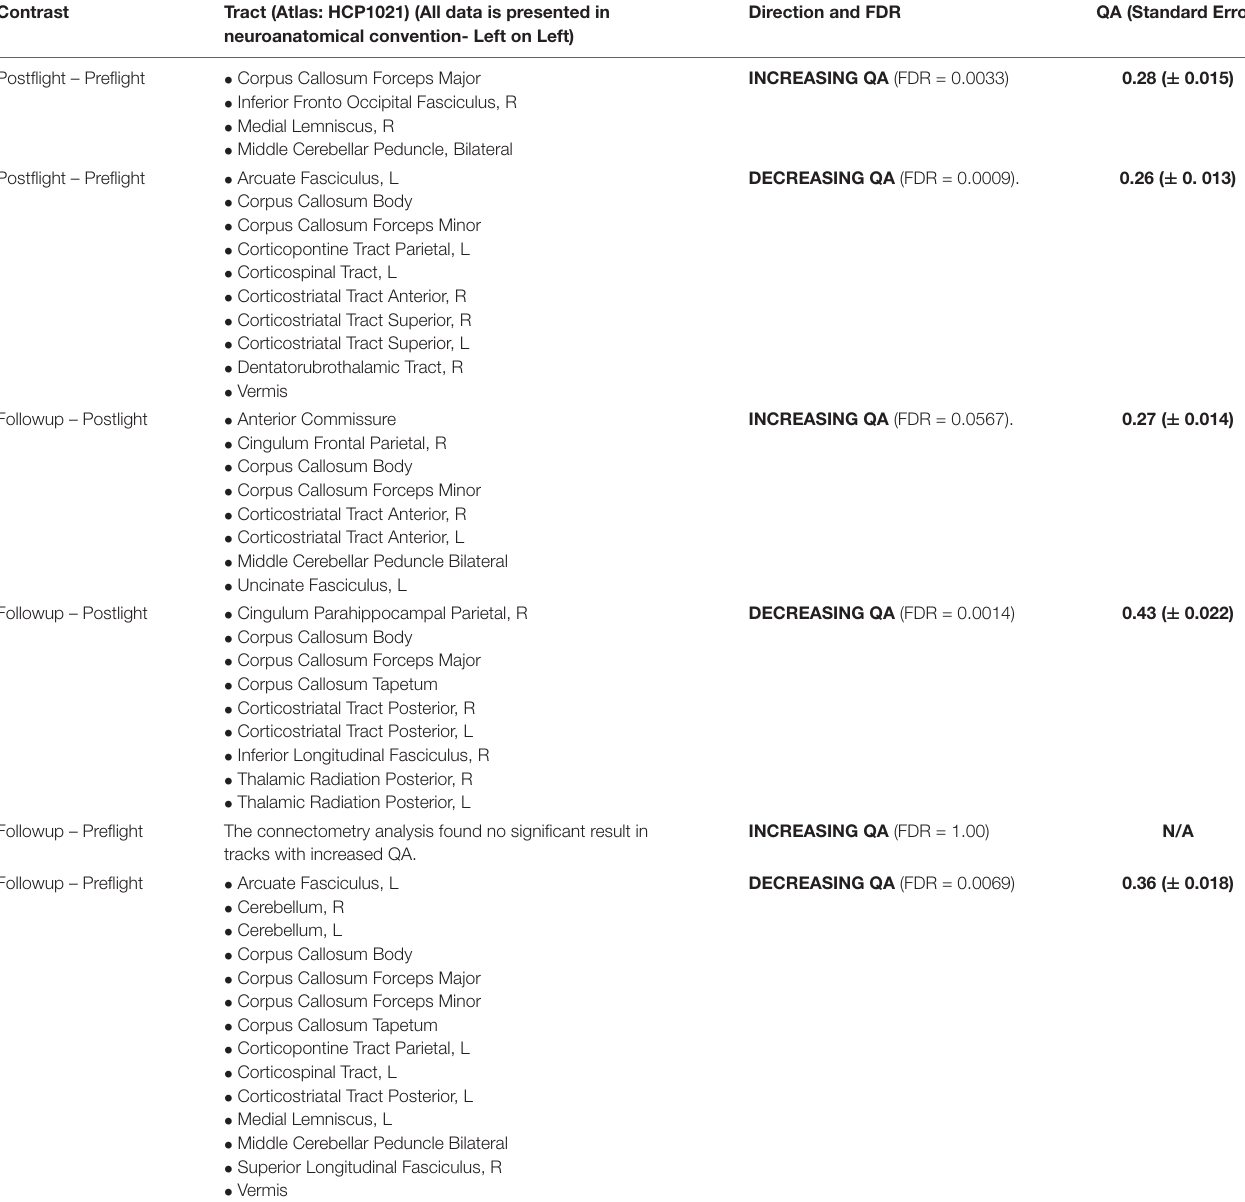
TABLE 2 | Overview of the tract labels that show changes in quantitative anisotropy (QA) for the different contrasts used in this analysis.